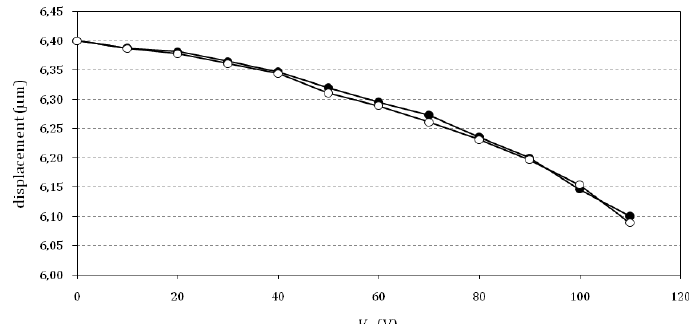
Figure 14: Static displacement of the structure (design 2) under two consecutive actuations; the material was excited in its elastic field.